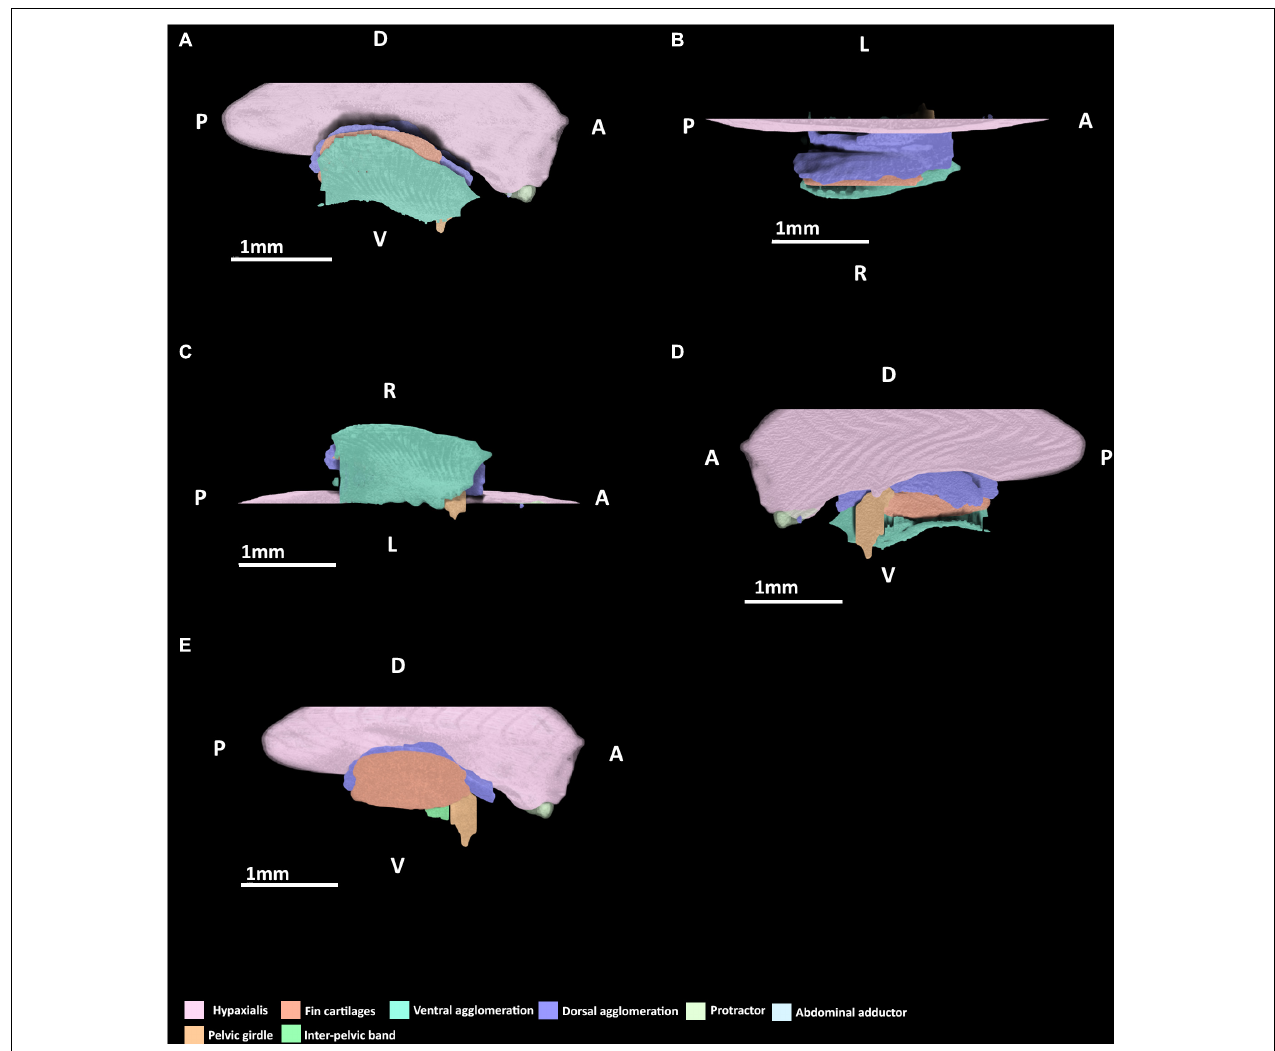
FIGURE 4 | 3D model of the right pelvic musculature of a stage 30 male elephant shark ( Callorhinchus milii ) embryo. (A) Lateral view of musculature, (B) dorsal view of the dorsal musculature, (C) ventral view of musculature, (D) medial view of musculature, (E) lateral view with the ventral agglomeration removed. Anatomical planes and position indicated by lettering: A, Anterior; P, Posterior; D, Dorsal; R, Right; L,